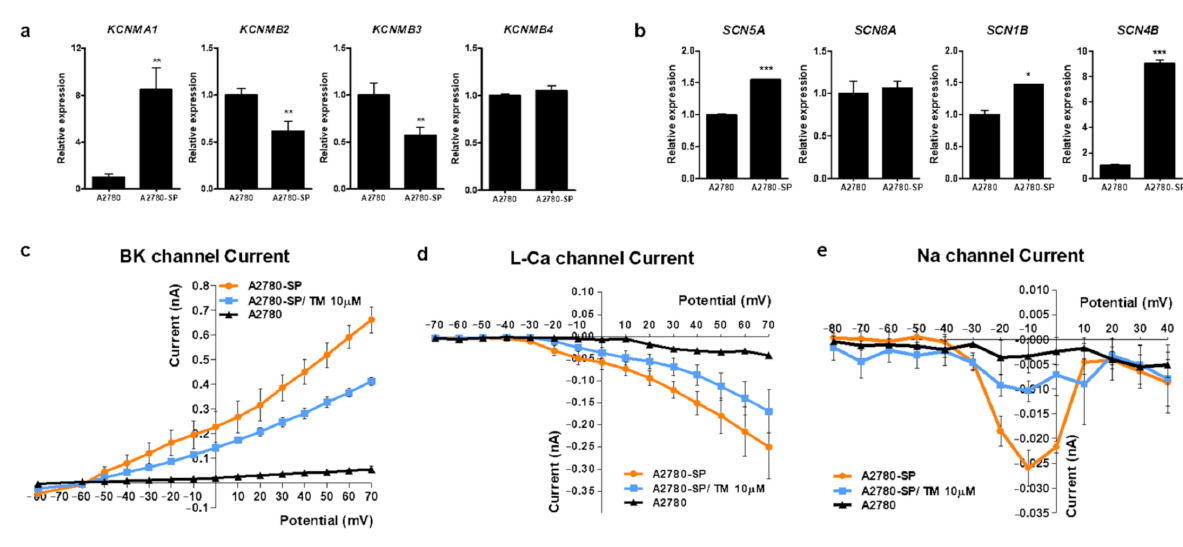
Figure 2. Subunits of BKCa and Na + channel are overexpressed on ovarian CSCs and TM can inhibit the current of Ca 2+ , BKCa and Na + channels. Compared mRNA expression levels of ( a ) BKCa channel genes ( KCMA1, KCMB2, KCMB3 , and KCMB4 ) and ( b ) voltage gated sodium channel genes ( SCN5A, SCN8A, SCN1B , and SCN4B ) in A2780-SP and A2780 cells, quantified by real-time PCR analysis. P values were determined by one-way ANOVA and GraphPad Prism 5 software (* p < 0.05; ** p < 0.01; *** p < 0.001). Currents of calcium ( c ), BKCa ( d ), and Na + ( e ) in A2780 and A2780-SP cells, measured using the whole-cell patch clamp technique. After measuring the normal current in A2780-SP cells, 10 µ M of TM was applied for 5 min, and the change in the current amplitude by TM was measured using the same